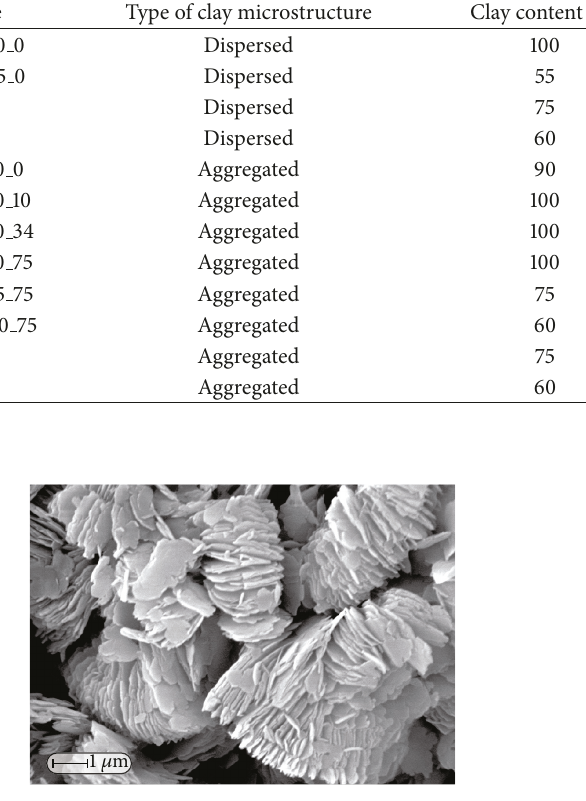
Figure 2: Aggregates of the kaolinite particles.